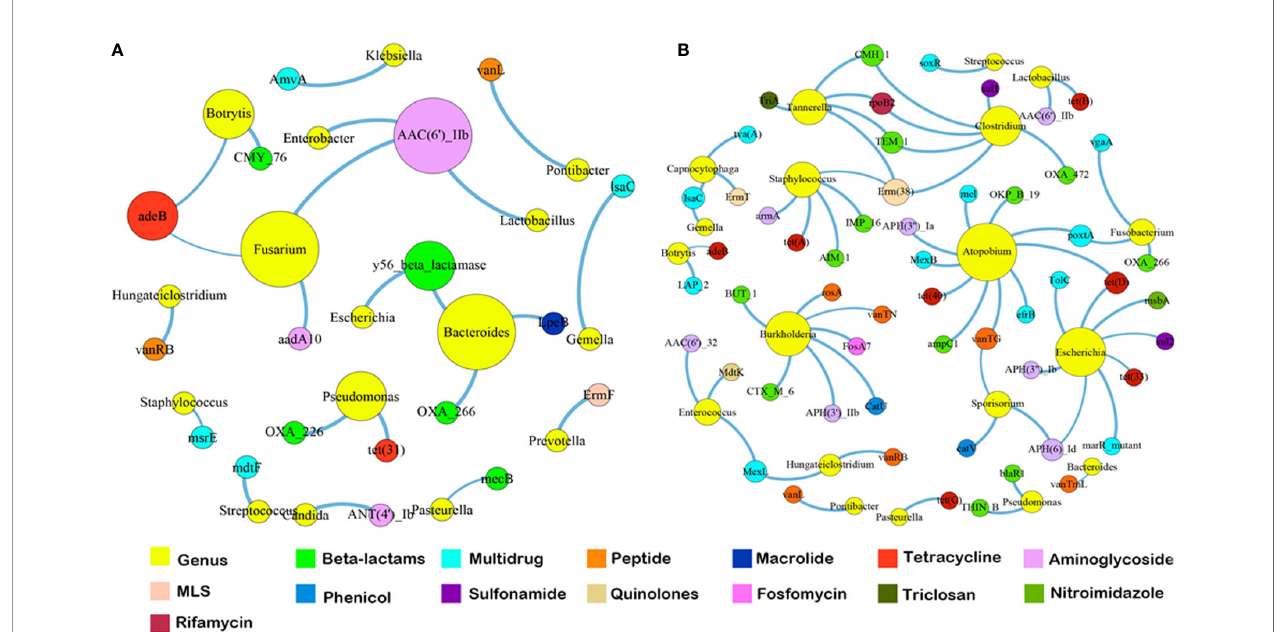
FIGURE 5 | The co-occurrence networks among ARGs and bacterial genera in HA-SA type (A) and LA-SA type (B) . In the graph, each dot represents a kind of ARG or bacterial genera. The nodes are colored yellow represent bacterial genus; others colored according to ARG types. The size of each node is proportional to the number of its connections (degree). Each line (edge) represents the co-occurrence of two objects. Edge width is proportional to Spearman ’ s r